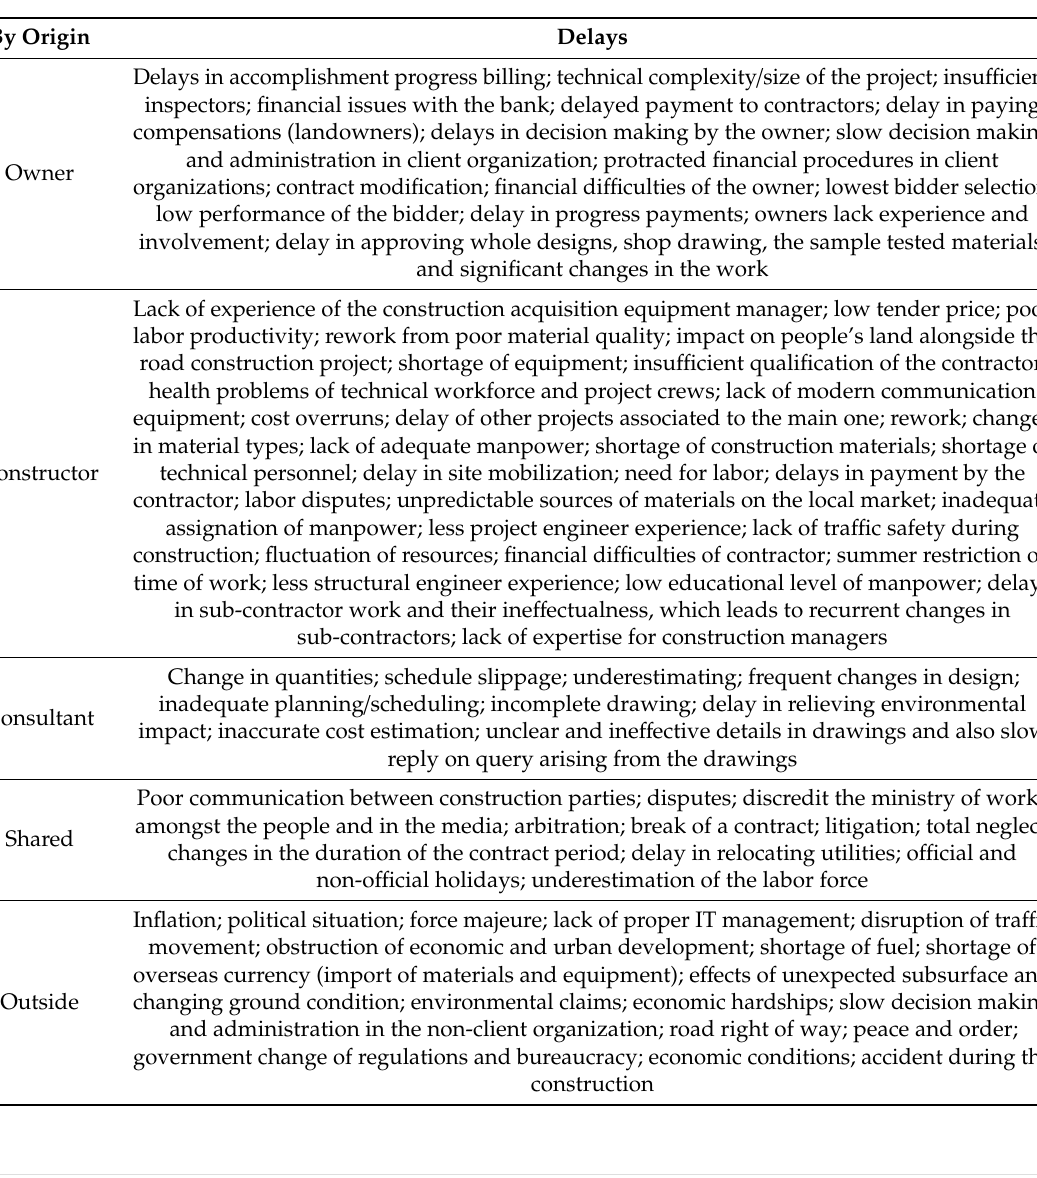
Table 2. Causes of delay.